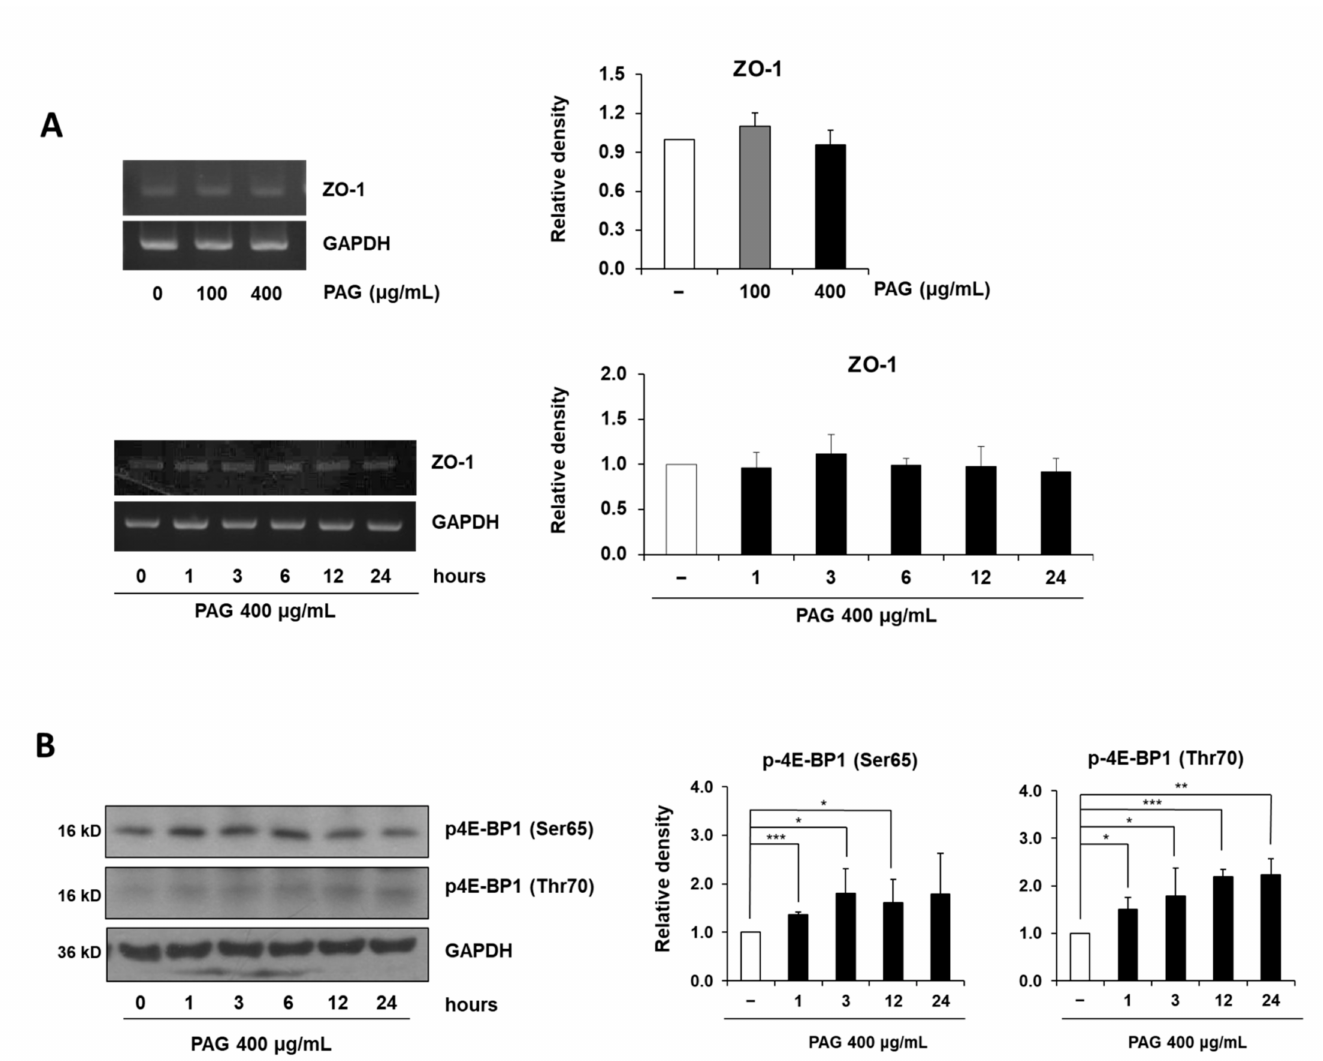
Figure 3. PAG increases expression level of ZO-1 at translation level. ( A ) Dose-dependent and time-dependent alterations of ZO-1 at the mRNA level in Caco-2 monolayers treated with 400 µ g/mL PAG; ( B ) PAG 400 µ g/mL exposure time-dependently induces phosphorylation of the translation repressor 4E-BP1 and ERK1/2 in Caco-2 monolayers. Values are presented as mean ± standard deviation (Student t -test was applied for statistical analysis, * p < 0.05, ** p < 0.01, *** p <